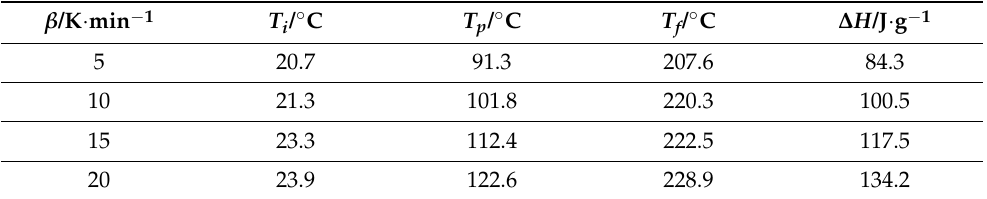
Figure 1. DSC results of the MDI-based polyurethane at different heating rates. Table 1. Characteristic temperatures and exothermic enthalpy of the MDI-based polyurethane at different heating rates.